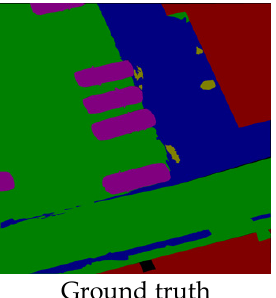
Figure 15. The RGB orthomosaic image for the second test site.